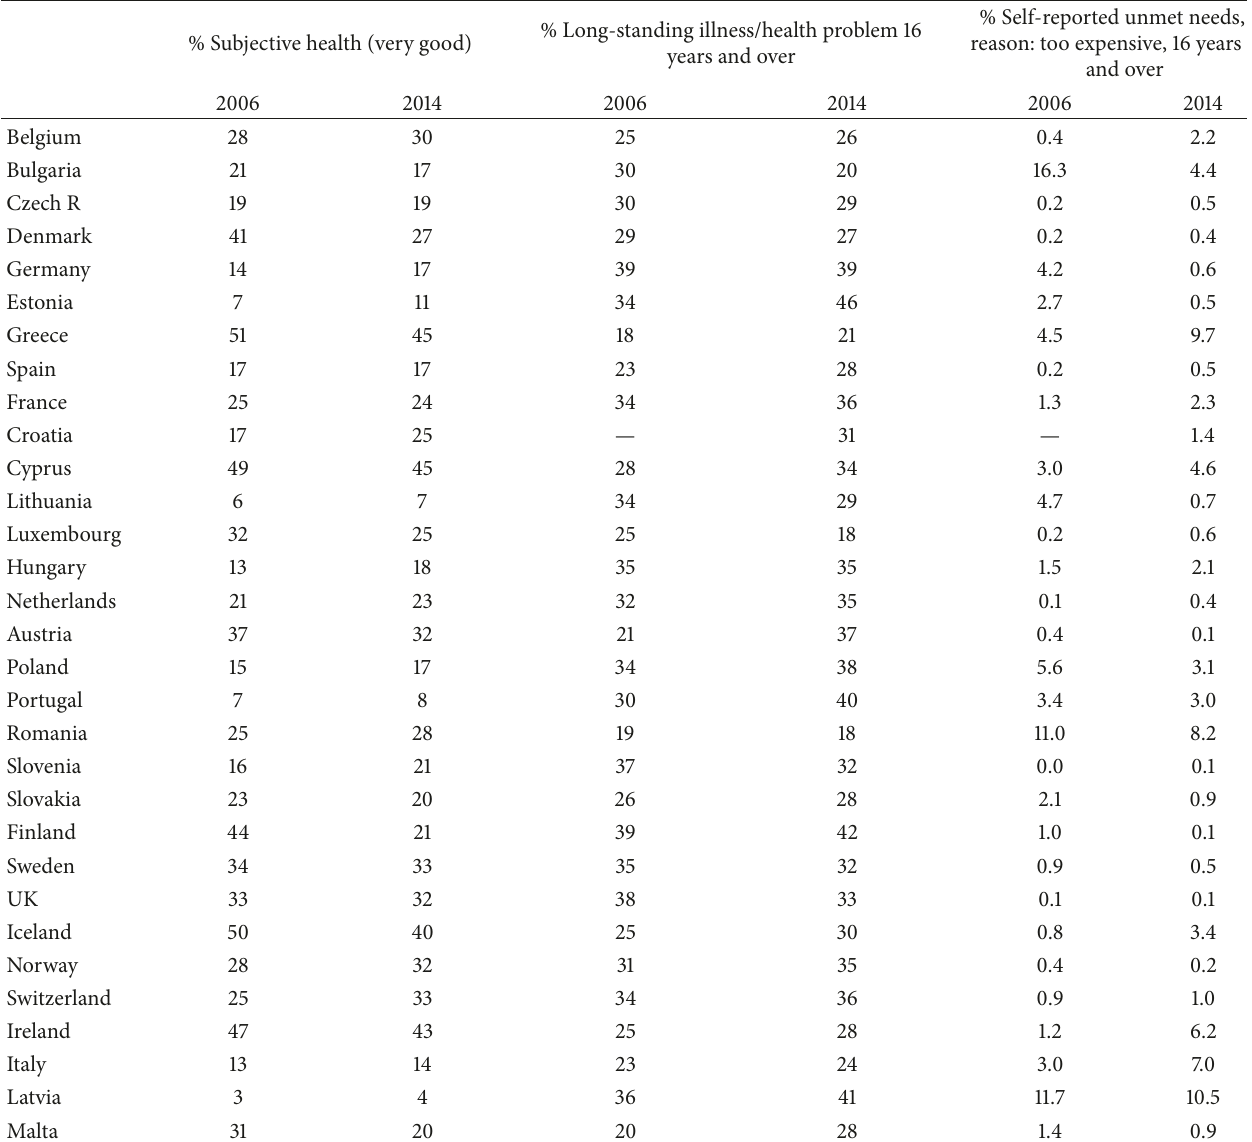
Table 4: Mean scores on the health indicators subjective health, percentage of long-standing illness/health problem, and percentage of self- reported unmet needs because they were too expensive per country in 2006 and 2014.